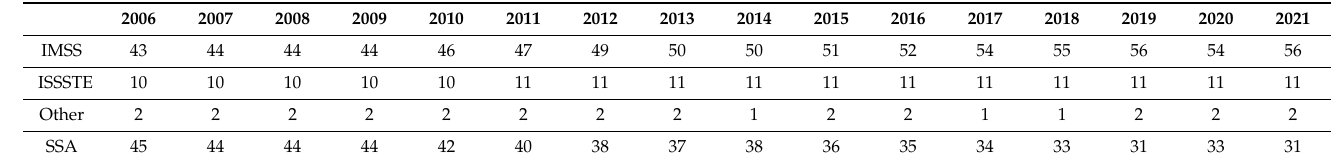
Table 2. Percentage of the population per institution per year